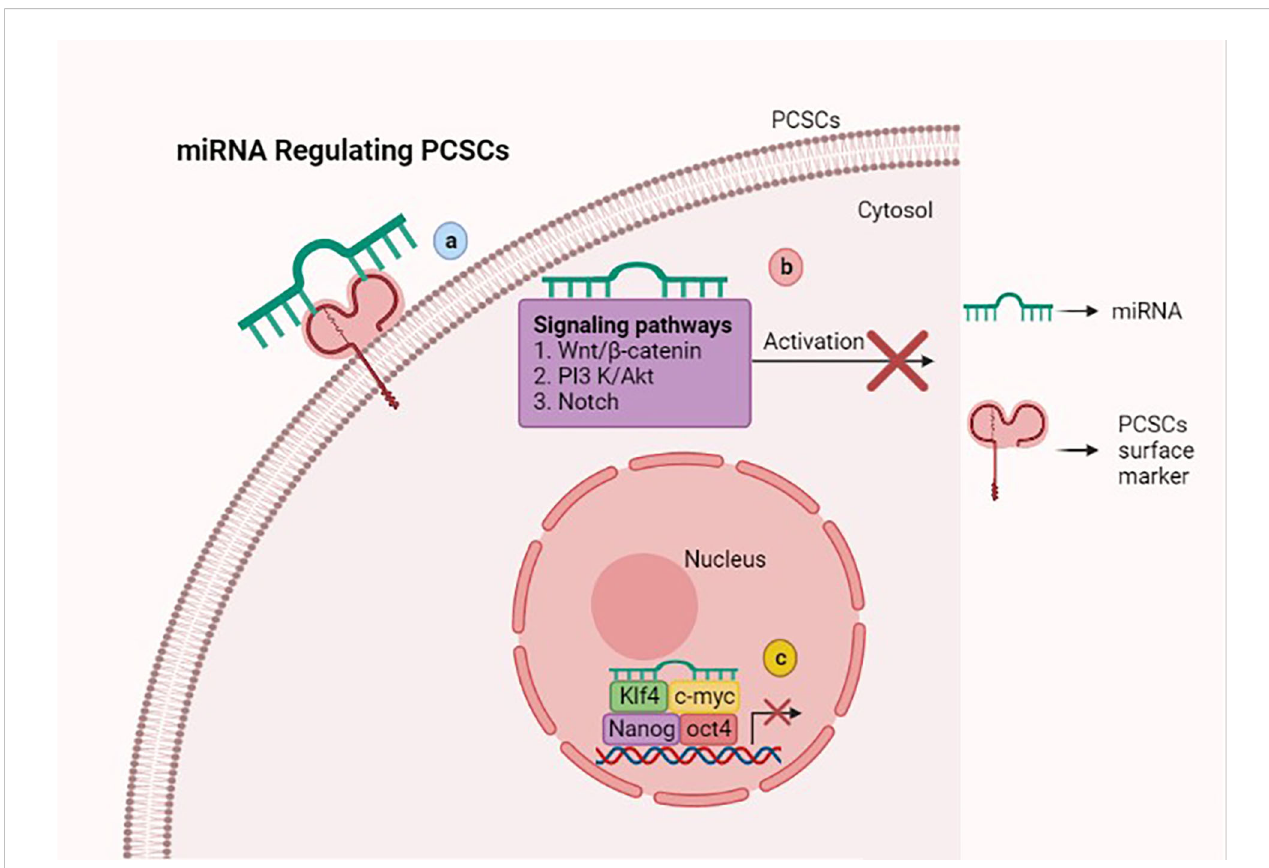
FIGURE 2 Scheme showing that microRNAs (miRNAs) regulate stemness features of prostate cancer stem cells (PCSCs) via various mechanisms. (A) miRNAs inhibiting stem-like traits of PCSCs via targeting the surface marker. (B) Attenuating Wnt/ b -catenin, PI3K/AKT, and Notch signaling pathways with miRNAs suppresses PCSC growth and induces cell death. (C) miRNAs suppress the stem cell-related transcription factors such as OCT4, KLF4, Nanog, and c- myc , which hamper PCSC stemness properties. This fi gure was created with